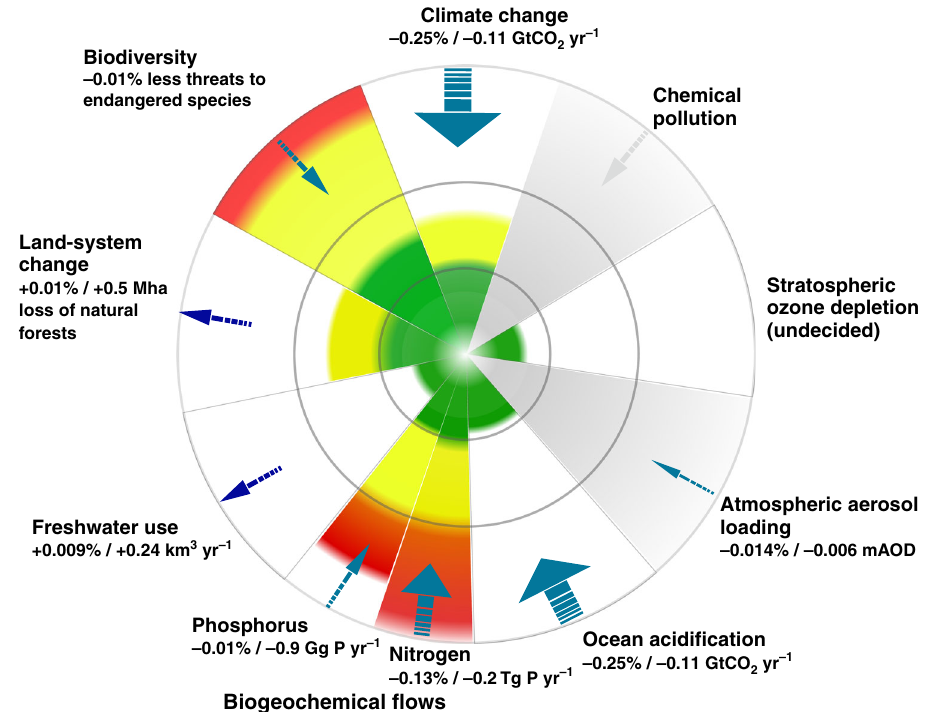
Fig. 2 Changes in planetary pressures resulting from a one percentage point increase in the carbon tax. This fi gure is a modi fi cation of the original planetary boundary fi gure from refs. 1,3 . The colors indicate the current state for each boundary: green, yellow, and red correspond to safe, increasing risk and high risk, respectively. We have added arrows illustrating the effects on each individual ESP, from increasing the carbon tax rate by one percentage point in our integrated model of the global economy and the ESPs. The direction of the arrows indicate increasing or decreasing pressure, while the width of the arrows are indicative of the magnitude of change. For chemical pollution and stratospheric ozone depletion, we only derived the qualitative direction of change. Further details are given in Supplementary Table